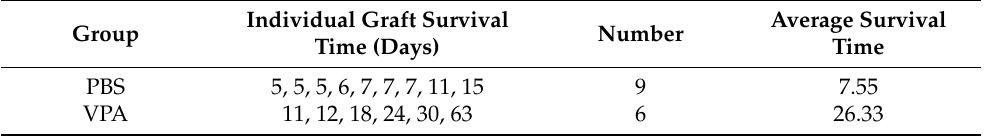
Figure 2. The effect of VPA treatment in the syngeneic and allogeneic islet transplantation of non- obese diabetic (NOD) and B6 mice. ( A ) The survival time of Syngeneic islet grafts was significant longer in VPA-treated group ( n = 6) compared to the PBS-treated group ( n = 9, ** = p < 0.001). The survival time of islet grafts in VPA-treated mice was significantly prolonged to 63 days ( n = 6, ** = p < 0.001 compared to the PBS-treated groups). ( B ) In the allogeneic islet transplantation, the survival of islet grafts in the streptozotocin (STZ)-induced diabetic C57BL/6 was significantly longer in the VPA treat-ed group compared to the PBS-treated controls ( n = 6). Histological assay indicated that islet grafts were destructed at day 10 in the kidney subcapsular space of ( C ) PBS-treated NOD recipients. In contrast, ( D ) the islet grafts were presented in the VPA-treated NOD recipients. The secretion of insulin was assessed by immunohistochemical staining. Red arrow indicates the insulin staining in the ( E ) PBS-treated group and the ( F ) VPA-treated recipients. Table 1. The survival time of syngeneic islet graft in the NOD